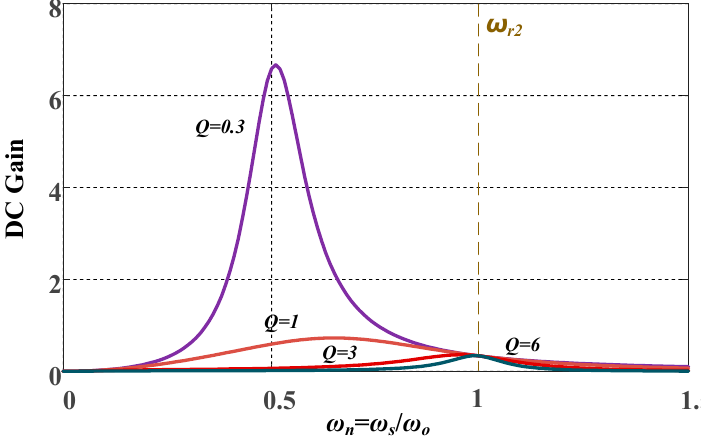
Figure 12. DC gain characteristics of the LCL resonant network.